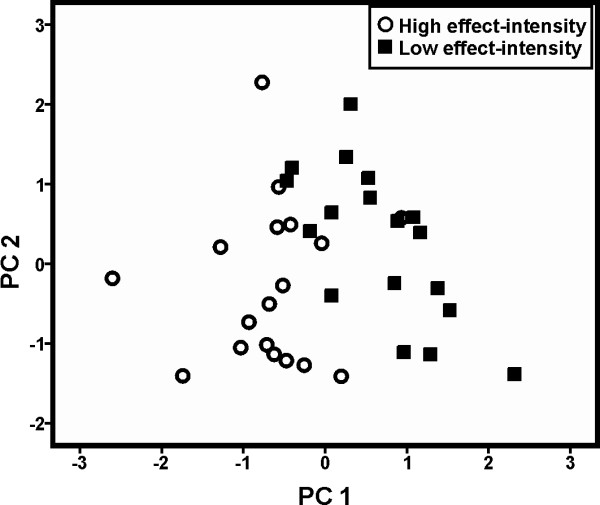
Scatterplot for the PC1 and PC2 of the arousal analysis.